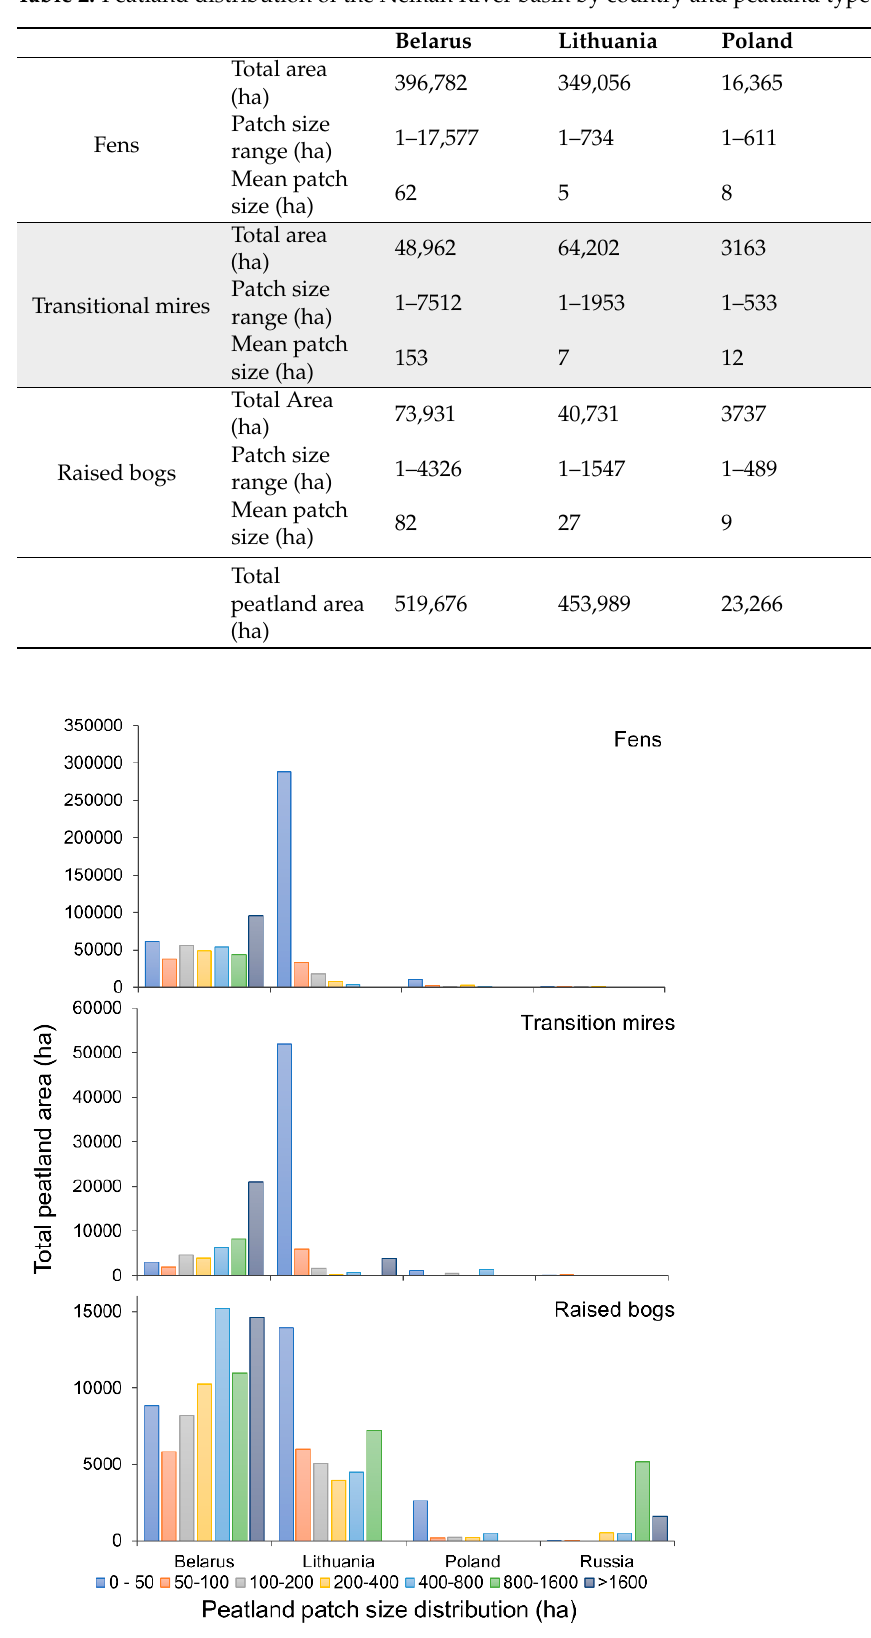
Table 2. Peatland distribution of the Neman River basin by country and peatland type.